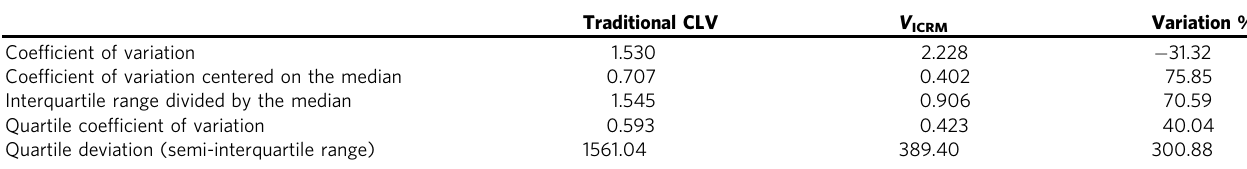
Table 10 Results of the dispersion statistics in the CLV and V ICRM